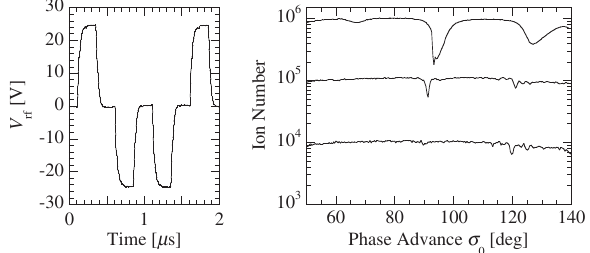
FIG. 12. Ion-loss distributions measured in S-POD with a FDDF focusing potential. The FDDF waveform employed for this experiment is symmetric as depicted in the left panel. The right panel shows the ion-loss distributions at three different initial plasma intensities. The storage period of 40 Ar þ ions in the LPT is fixed at 10 ms in all measurements. The small ripples in the low-density data are due to the performance limitation of our pulse-waveform generator (rather than to the fluctuation of the initial ion